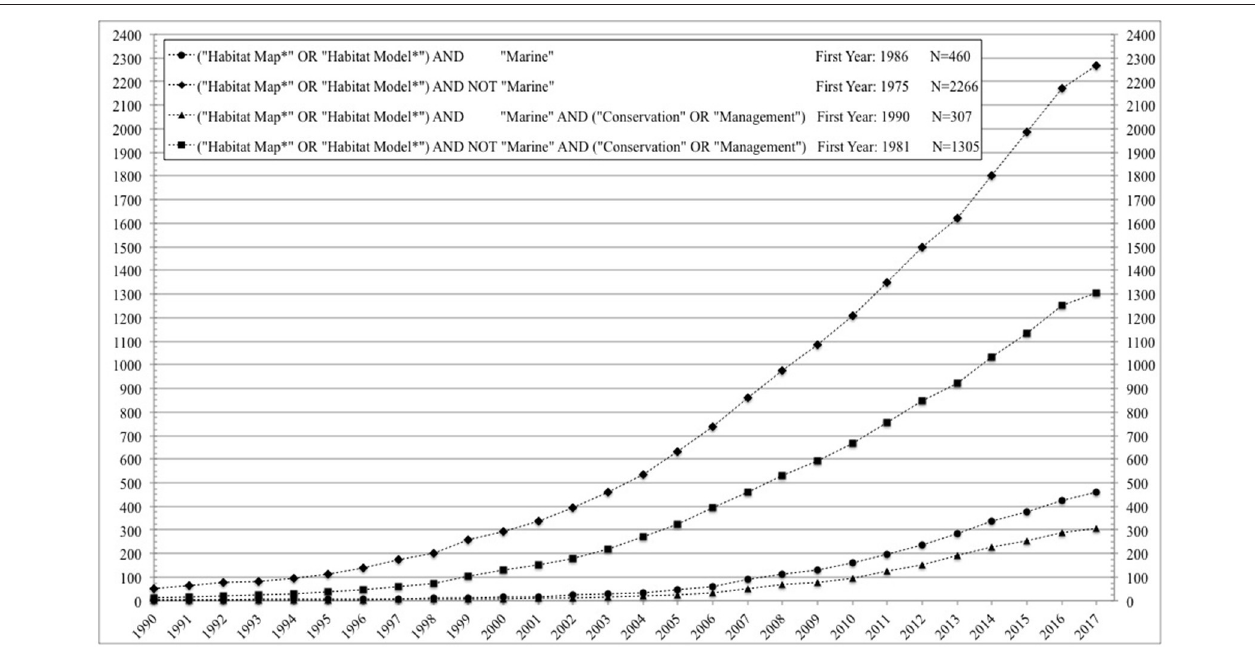
FIGURE 1 | Cumulative number of publications (articles or reviews) listed in the Scopus database mentioning specific keywords (see legend) in their title, abstract, or keywords, in July 2017.